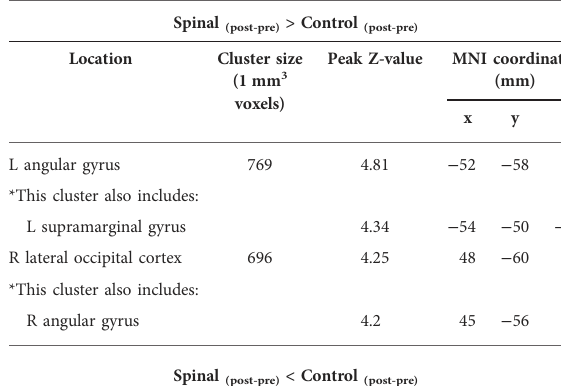
TABLE 3 Spinal anesthesia effect on heat pain stimulus.